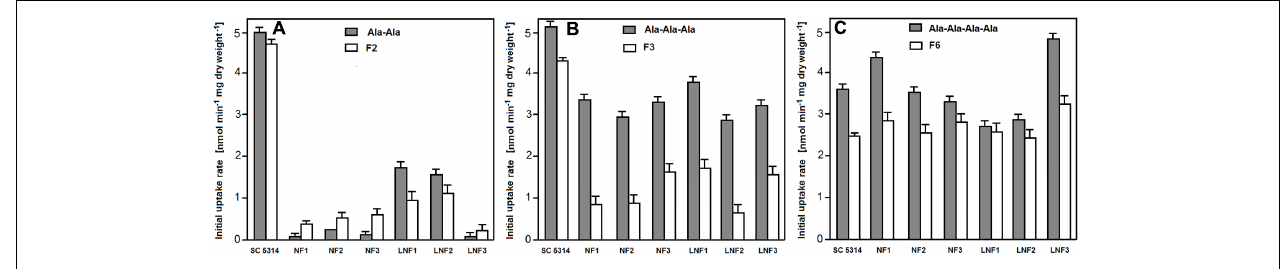
FIGURE 4 | Uptake rates of FMDP-oligopeptides and model alanyl peptides to isolates resistant to F2/F3. (A) Dipeptides. (B) Tripeptides. (C) (Ala) 4 and F6.